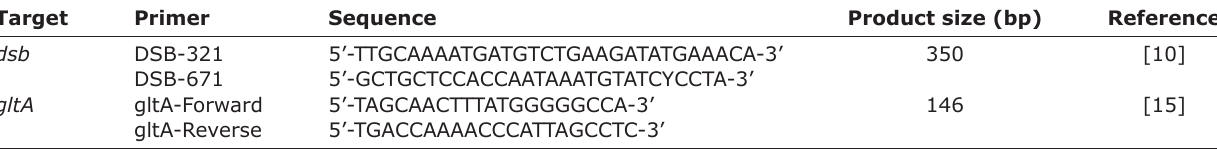
Table-1: Primers used for the amplification and sequencing of the dsb and gltA genes. Target